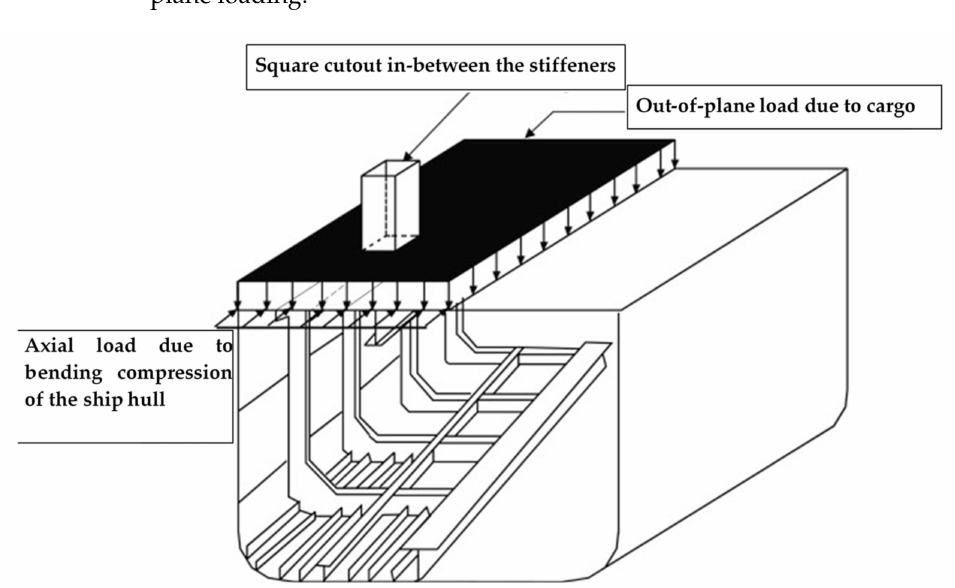
Figure 1. Typical ship deck composed of stiffened plates subjected to axial and out-of-plane